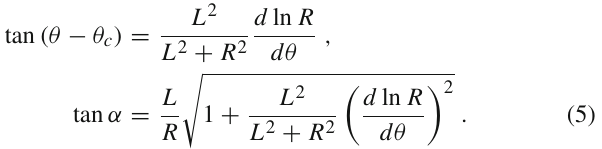
Fig. 2 Circle (8) in Poincaré AdS at t = 0, with some of its tangent geodesics, as given by (9). In this and all subsequent plots in this paper, weset L = 1.Wehavechosenthecircletobecenteredat ( x , z ) = ( 0 , 2 ) ,